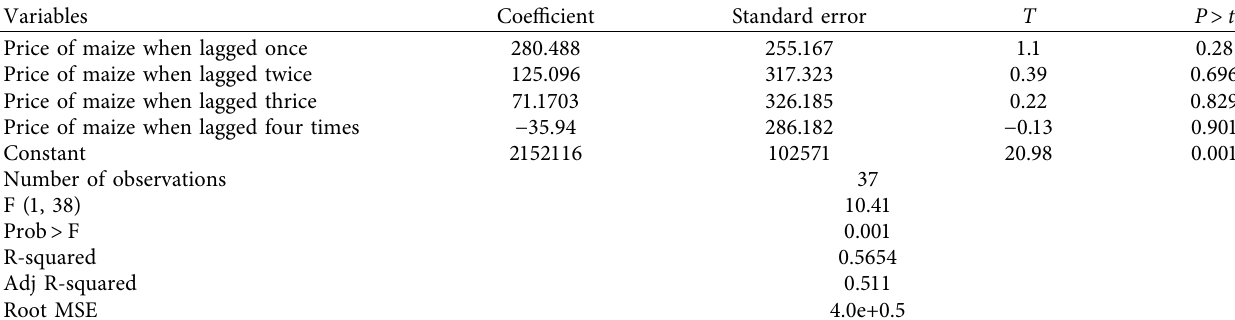
Table 3: OLS regression of maize production against lagged prices of